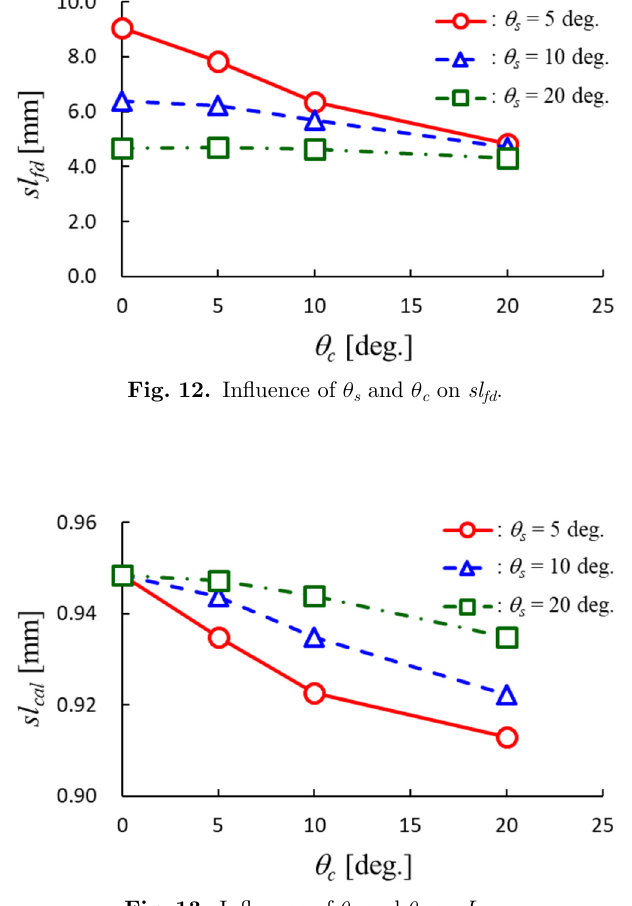
Figure 14. In the fi gure, each curve for respective u s in